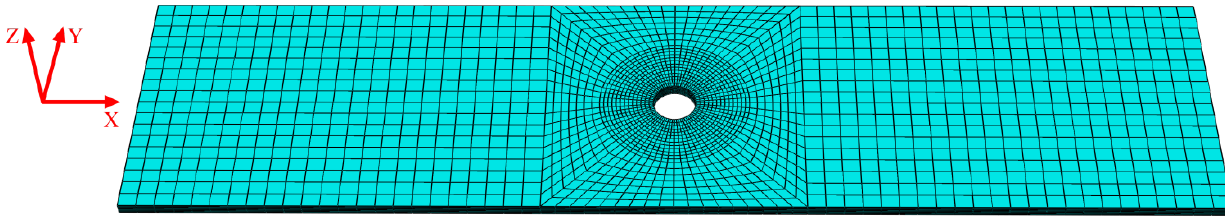
Figure 4. Finite element model of the GFRP laminate specimen with the global coordinate